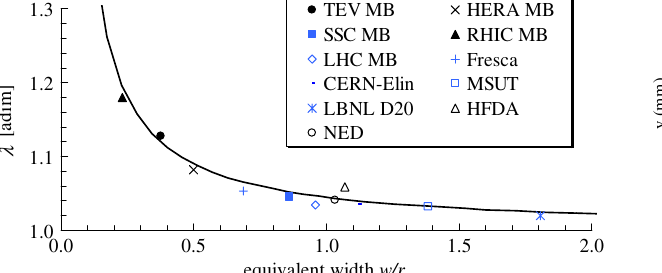
FIG. 15. Cross section of the INFN SIS-300 proposed model (left), and value of (cid:7) (full marker) compared to the fit (18) and to numerical values (empty markers) of magnets shown in Fig.